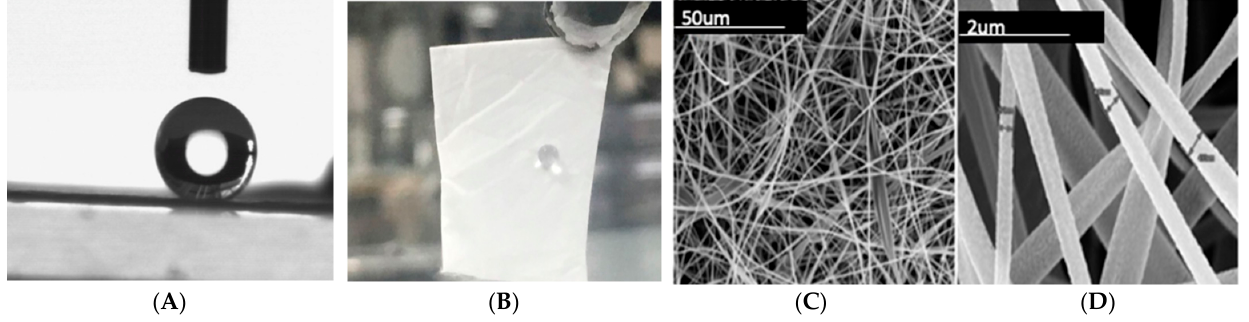
Figure 3. Super-water-repellant cellulose acetate electrospun mats for filtration applications [15]: ( A ) water contact angle on CA mat; ( B ) super-water-repellant nature of the CA mat; ( C ) low-magnification SEM image of the fibrous mat; and ( D ) high-magnification SEM image showing the fiber characteristics. The physics of filtration is described in reference [16]. Particles larger than 50 nm can contact the fibers of the filter through the processes of interception and/or